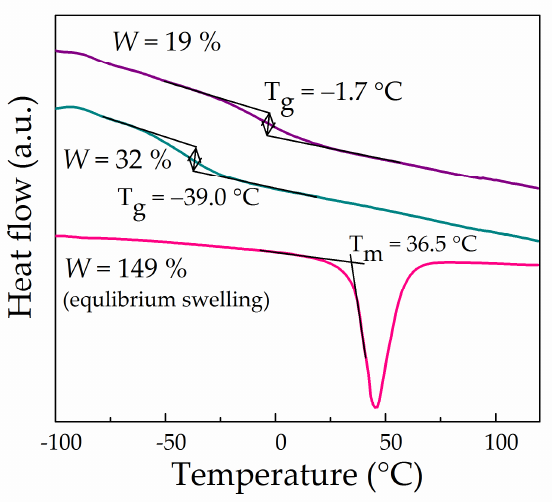
Figure 7. DSC curves for Li-Nafion with different contents of EC (40 °C/min). The obtained results indicate that even pure EC, which is solid at room temperature, represents a very effective plasticiser for Li-Nafion. The destruction of ionic crosslinking mobility of perfluorinated Nafion backbones. The structural rearrangements in the